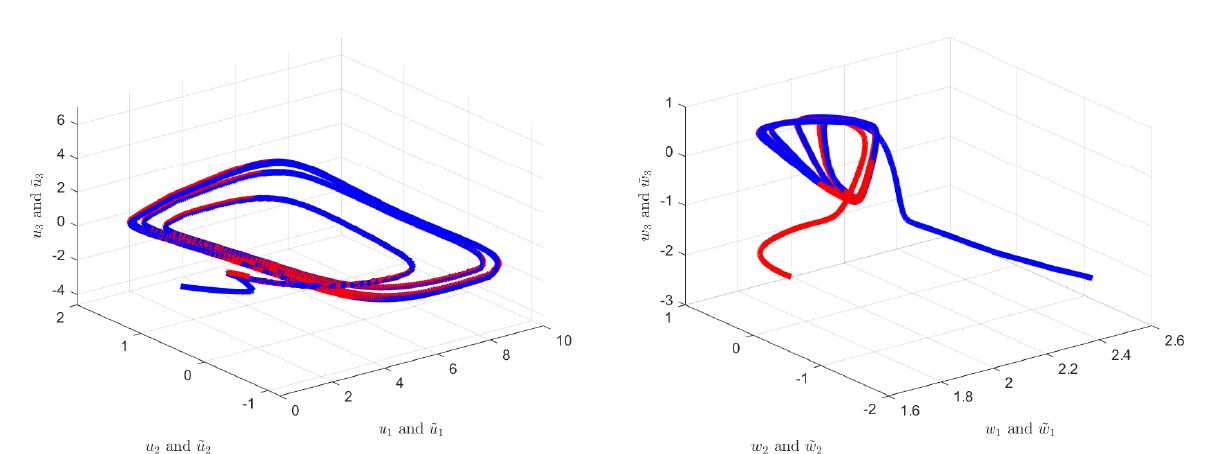
Figure 10. Time behaviors of error signals e 1 ( t ) , e 2 ( t ) , e 3 ( t ) , z 1 ( t ) , z 2 ( t ) and z 3 ( t ) with control input in Example 2.